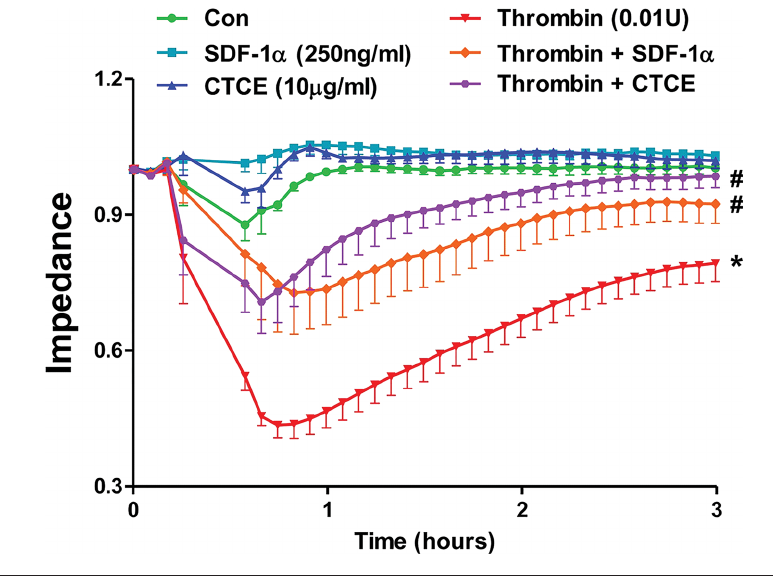
Figure 1. SDF-1 α and CTCE inhibited thrombin-induced permeability in HMVECs. HMVECs were treated with thrombin (0.01 U), SDF-1 α (250 ng/mL), CTCE (10 μ g/mL) or a combination of thrombin with SDF-1 α or CTCE. HMVEC permeability was determined by measuring electrical impedance using an ECIS system. Thrombin treated cells are sig- nificantly different (* p < 0.05) from control cells, and thrombin combined with SDF-1 α or CTCE groups are significantly ( # p < 0.05) different from thrombin group. Data were ana- lyzed using repeated-measures ANOVA. N = 4–5 independent